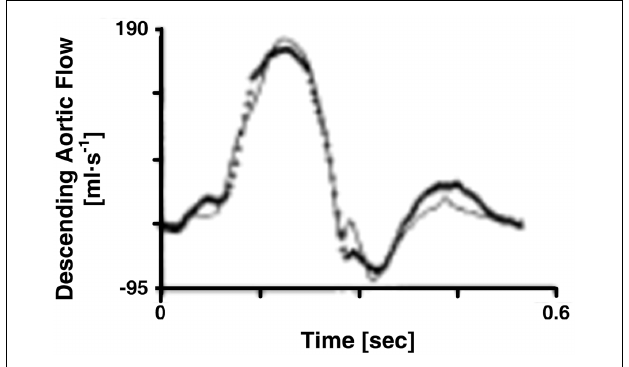
FIGURE 3 | Descending aortic flow waveforms measured (line with crosses) and predicted (solid line) from central aortic pressure and flow waveforms. Adapted from Burattini and Campbell